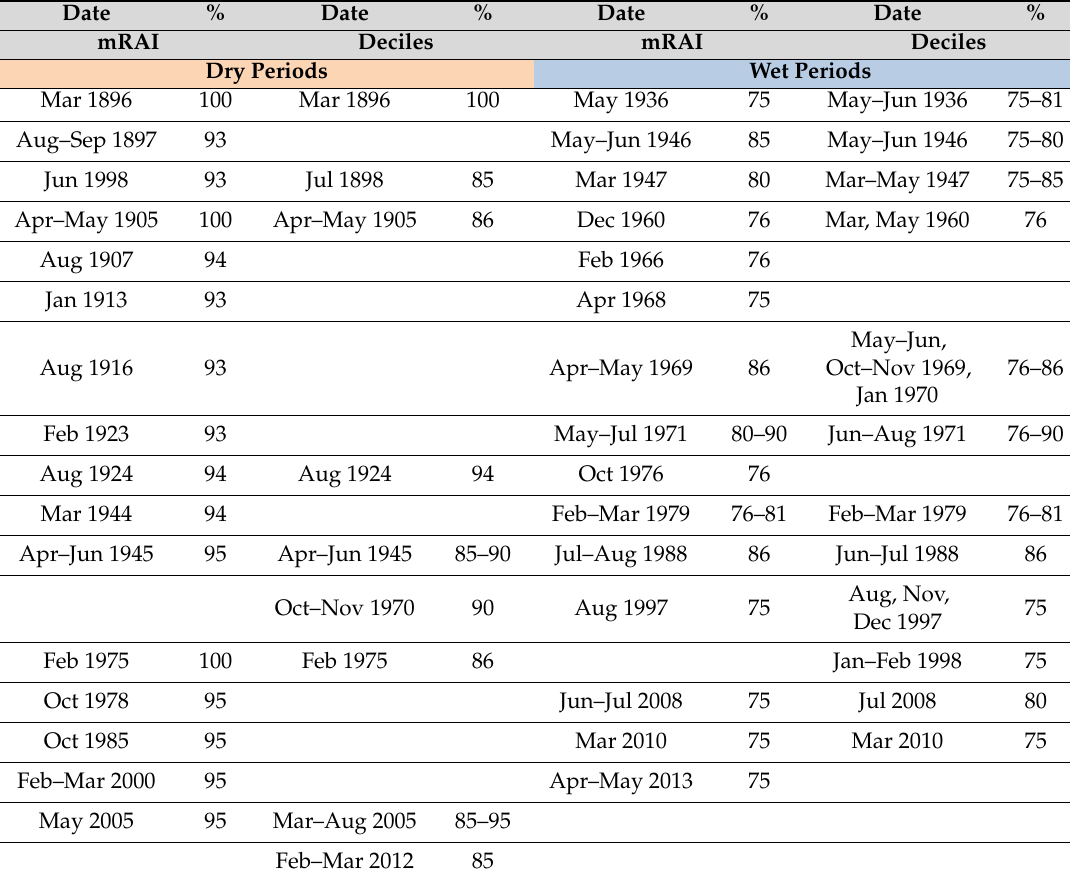
Table A6. Sub-region Iberian Peninsula—overview on the TOP20 months with the highest spatial extent of dry and wet periods within the study period